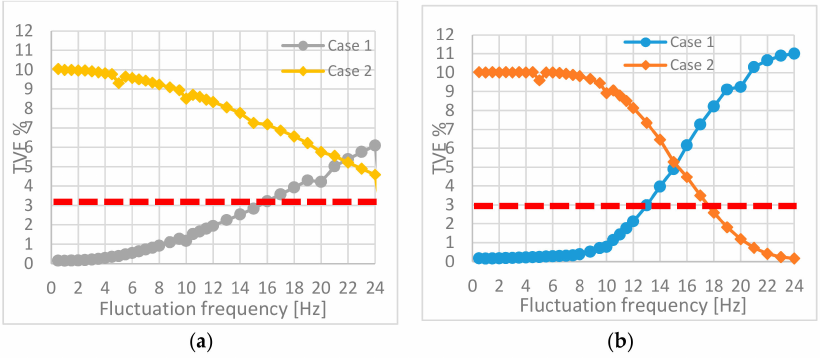
Figure 8. TVE results for PMU C with P ( a ) and M ( b ) configuration.